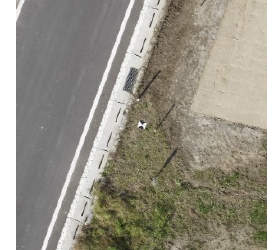
Figure 1. Orthoimage of a ROI